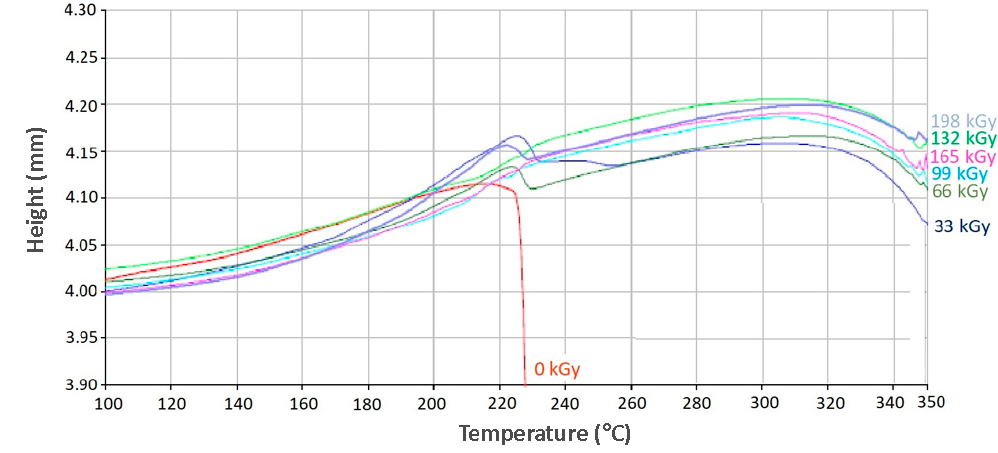
Figure 11. Thermo-mechanical analysis (TMA) (PA 6).